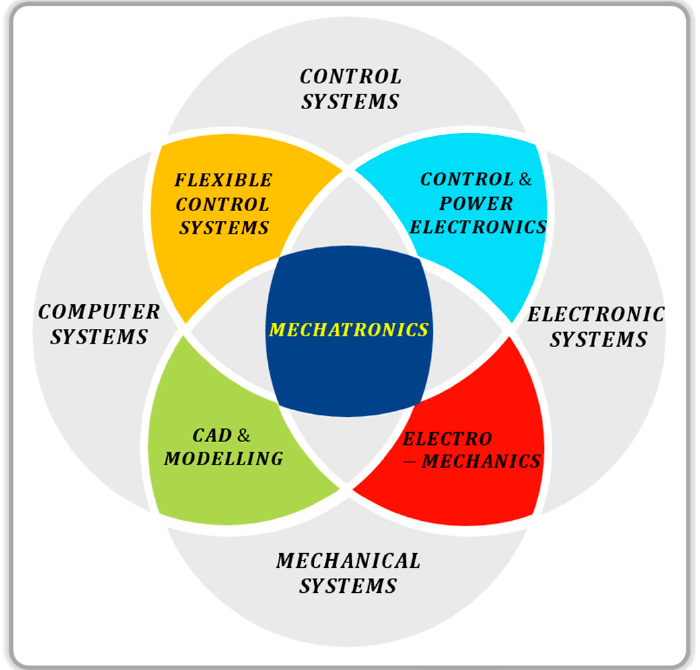
Figure 1. Euler diagram representation of mechatronics and its interdisciplinary branches of engineering.